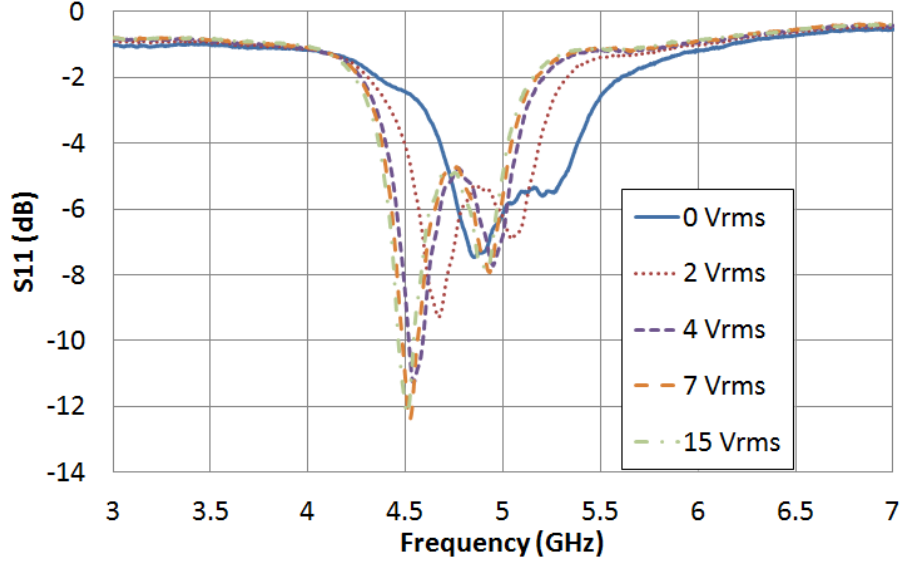
parameter for the new bandpass 11